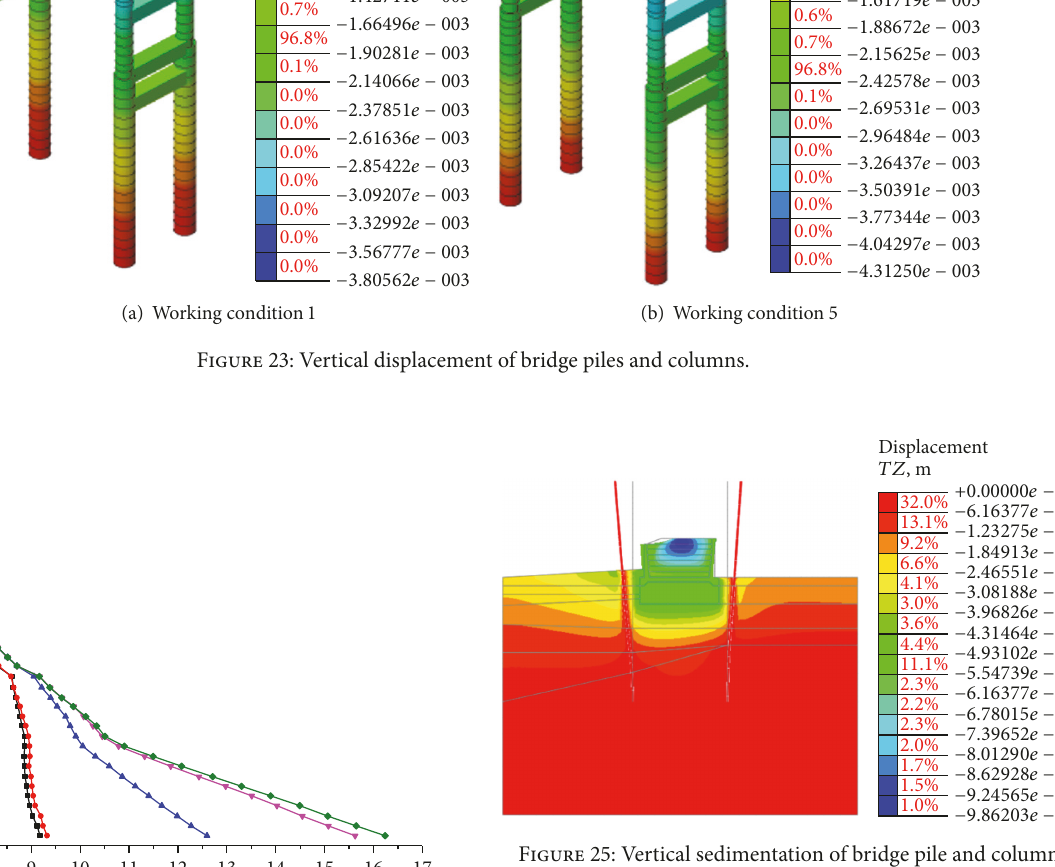
Figure 25: Vertical sedimentation of bridge pile and